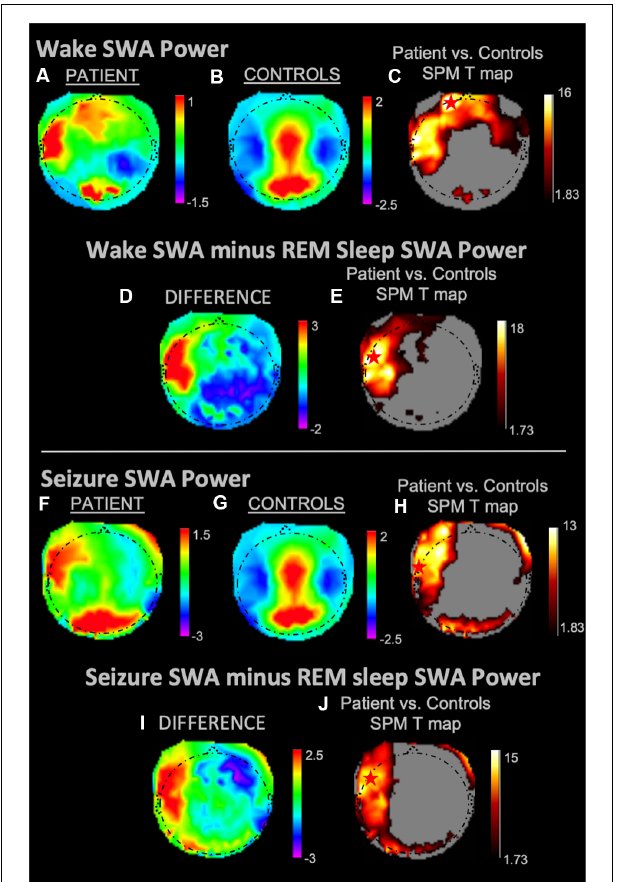
FIGURE 2 | SWA power topographies for the patient and controls during wakefulness and seizure states, both in isolation and when subtracted by REM sleep. Red stars denote SWA maximums. Wakefulness SWA analysis showed a left frontal maximum; when referenced to REM sleep, wakefulness SWA localized to the left fronto-temporal region. The seizure state displayed an SWA maximum in the left temporal region. We observed a left fronto-temporal region SWA maximum in the seizure state when referenced to intrasubject REM sleep SWA. (A) Wakefulness mean SWA power for the patient. (B) Wakefulness mean SWA power for controls. (C) SPM T map for the statistical difference between patient and controls wakefulness SWA; the red star shows the SWA maximum. (D) Difference between patient and controls SWA power during wakefulness subtracted by REM sleep SWA. (E) SPM T map for the difference between patient and controls SWA power during wakefulness subtracted by REM sleep SWA; the red star shows the SWA maximum. (F) Seizure mean SWA power for the patient. (G) Wakefulness mean SWA power for controls. (H) SPM T map for the statistical difference in SWA power between patient seizure and controls wakefulness; the red star shows the SWA maximum. (I) The difference in mean SWA power between patient seizure and wakefulness of controls, both subtracted REM sleep SWA. (J) SPM T map for patient seizure and controls wakefulness subtracted by REM sleep SWA; the red star shows the SWA maximum. Each T map pictured above is thresholded for a display of uncorrected p < 0.05. The rainbow color scale is utilized for regression slope values and the hot color scale for t -values.